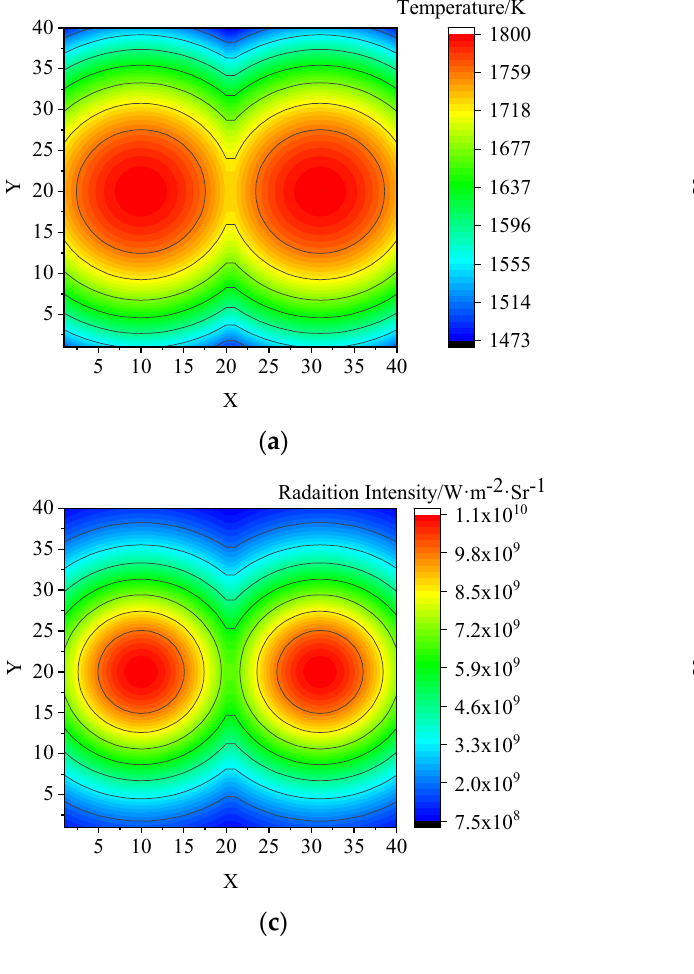
Figure 3. Cross-sections of the assumed twin-peaks flame for numerical simulation: ( a ) temperature distribution of the flame; ( b ) soot-concentration distribution of the flame; ( c ) radiation source-term distribution of channel R and ( d ) radiation source-term distribution of channel G .